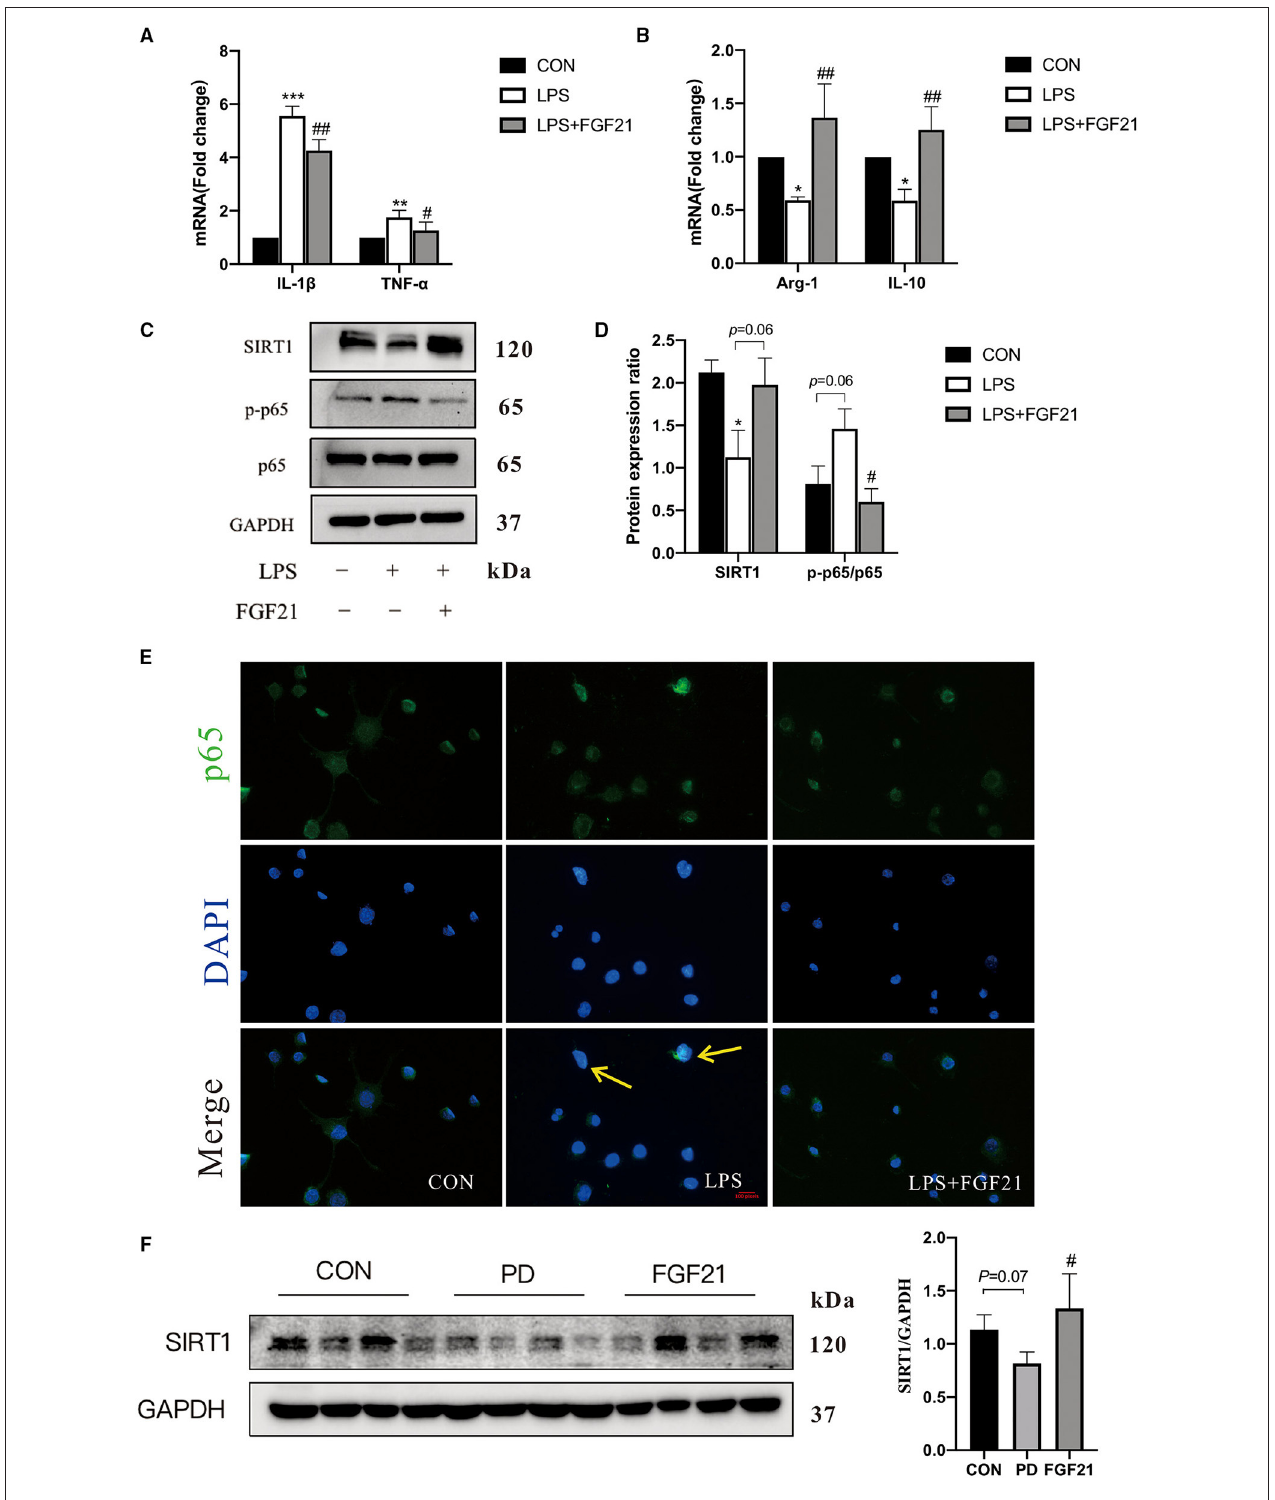
FIGURE 5 | FGF21 inhibited LPS-induced microglial activation in BV2 cell cultures. Real-time PCR analysis of M1 and M2 gene markers in BV2 cells (A,B) . (C) Representative immunoblots of SIRT1, phosphorylated protein (p-p65), p65, and GAPDH in BV2 cells in response to LPS with or without FGF21 treatment (100ng/ml). (D) Quantification of SIRT1 and p-p65 levels normalized to GAPDH. Data are mean ± s.e.m, n = 3 samples. (E) FGF21 inhibits translocation of NF- κ B p65 from the cytosol to the nucleus. (F) Protein levels of SIRT 1 in the ventral midbrain of CON, PD, and FGF21 mice. A one-way ANOVA analysis was conducted followed by an LSD multiple comparison test. * P < 0.05, ** P < 0.01, *** P < 0.001 vs. intact cells; # P < 0.05, ## P < 0.01 vs. LPS-treated cells.